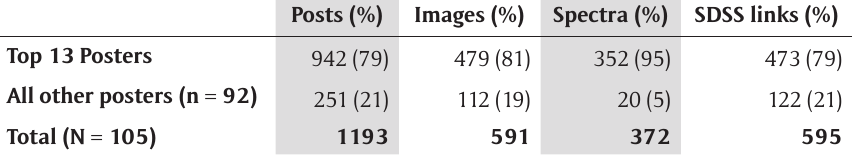
Table 4: Distribution of contribution: This table compares the contributions from the top 13 posters to all other posters (n = 92). The number indicates how many posts contain the object